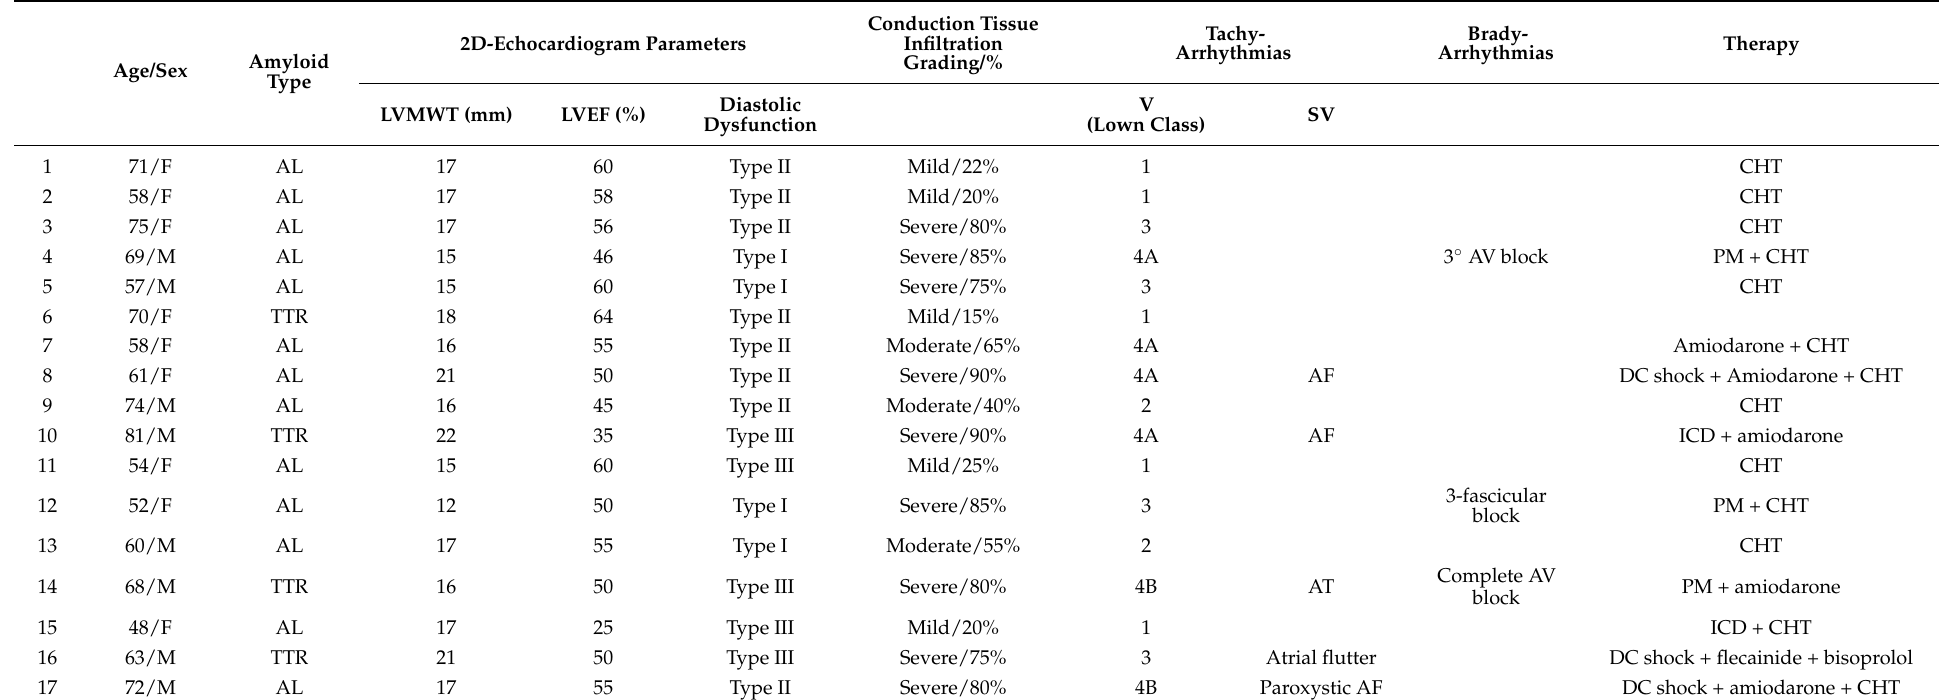
Table 1. Clinical data and CT infiltration in 17 patients with cardiac